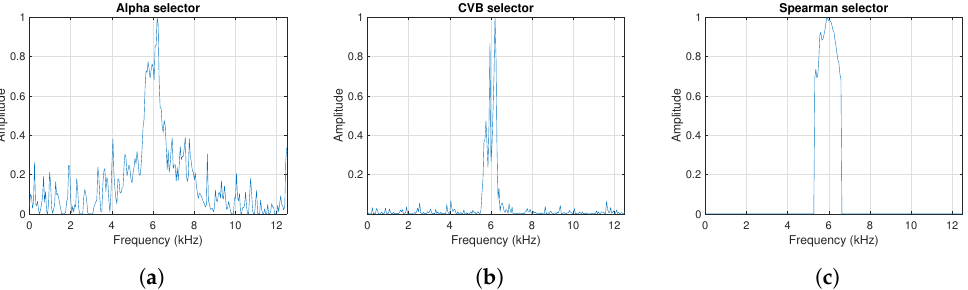
Figure 31. IFB selectors for the simulated signal s 4 . ( a ) Alpha selector. ( b ) CVB selector. ( c ) Spearman